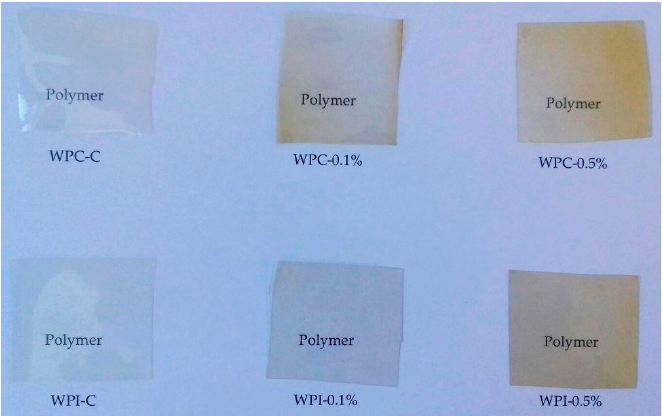
Figure 1. The visual appearance of neat and modified WPC/WPI films.